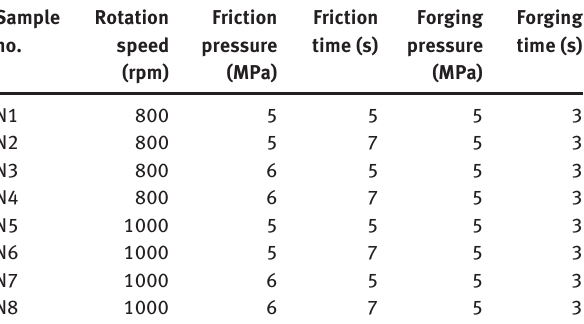
Table 1 Friction welding parameters used in the study.